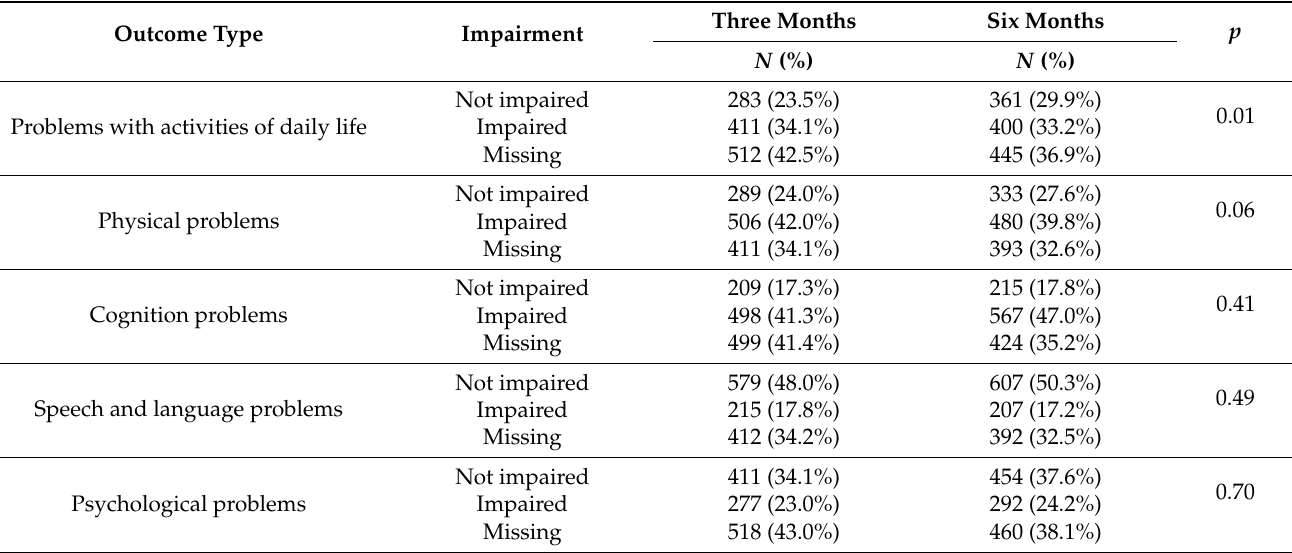
Table 2. Impairment in the different outcome areas at three and six months after